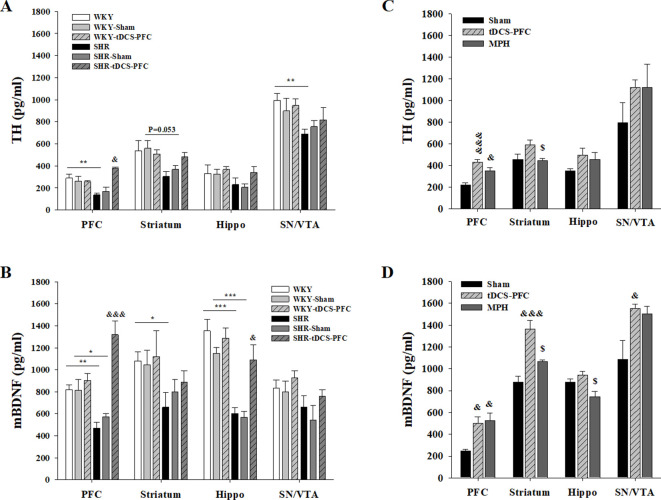
Effect of HD-tDCS application over the prefrontal cortex on free TH and mBDNF levels.(A, B) Free TH and mBDNF levels measured by ELISA at 2 days after the last HD-tDCS application in our ADHD rat model and its WKY control strain (n = 4). In the ADHD rat model, TH and mBDNF levels were significantly increased in the prefrontal cortex in the SHR-tDCS-PFC group compared to the sham group. mBDNF levels were also significantly increased in the hippocampus in the SHR-tDCS-PFC group. (C, D) Free TH and mBDNF levels measured by ELISA at 8 days after the last HD-tDCS application in our rat model of ADHD (n = 4). Levels of TH were significantly increased in the prefrontal cortex in the tDCS-PFC and MPH-treated groups compared to the sham group. mBDNF levels were markedly increased in the prefrontal cortex, striatum, and SN/VTA in the tDCS-PFC group compared to the sham group. Data are presented as the mean ± SEM. &p<0.05 and &&&p<0.001 vs. sham, $p<0.05 vs. tDCS-PFC.Figure 2—source data 1.Source files for quantification of ELISA analysis.This zip archive contains all source data for ELISA analysis shown in Figure 2.